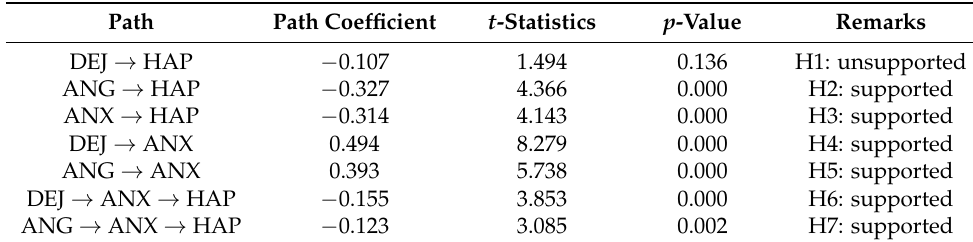
Table 8. Hypotheses testing results.